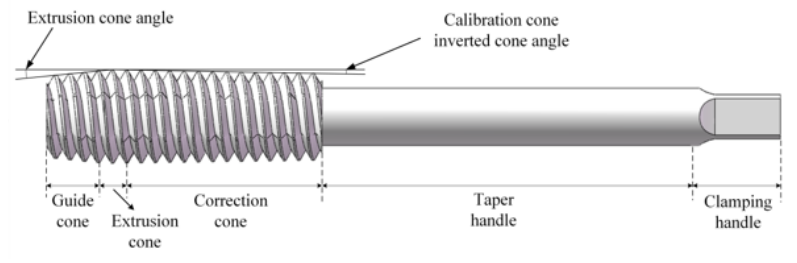
Figure 3. Extrusion tap geometry model.